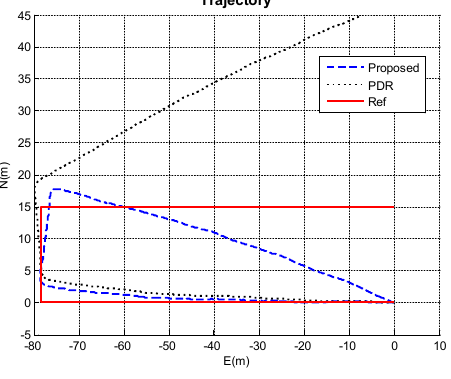
Figure 4. Trajectories of PDR, PDR/INS integrated MEMS solution, and the